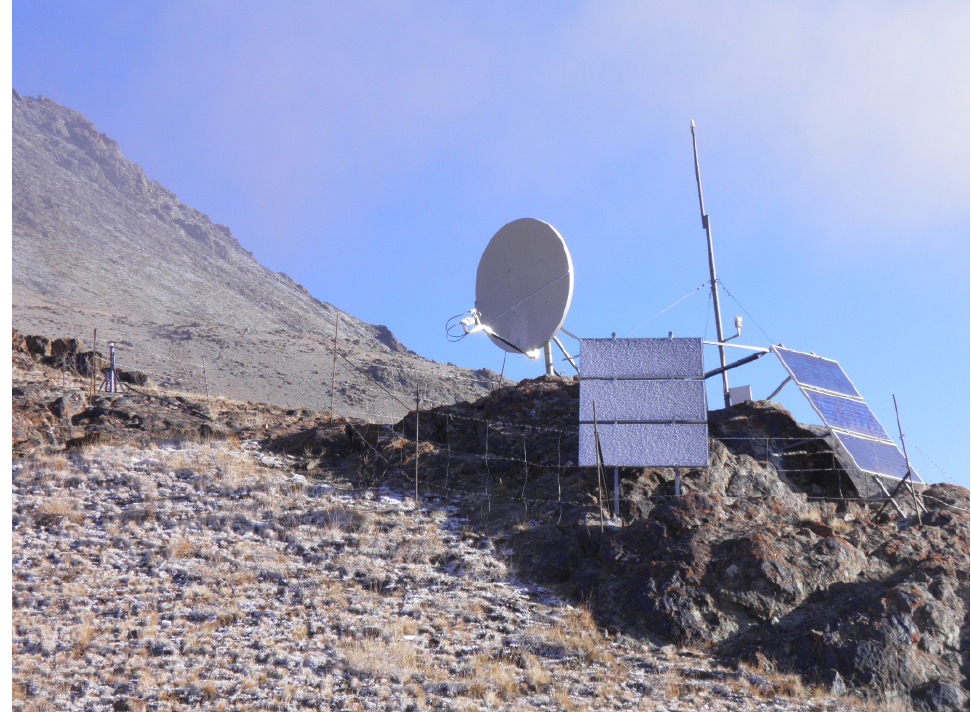
Figure 3. Station type two with a compact weather transmitter connected at the pole between the solar panels at the station Alai-6 (ALA6).